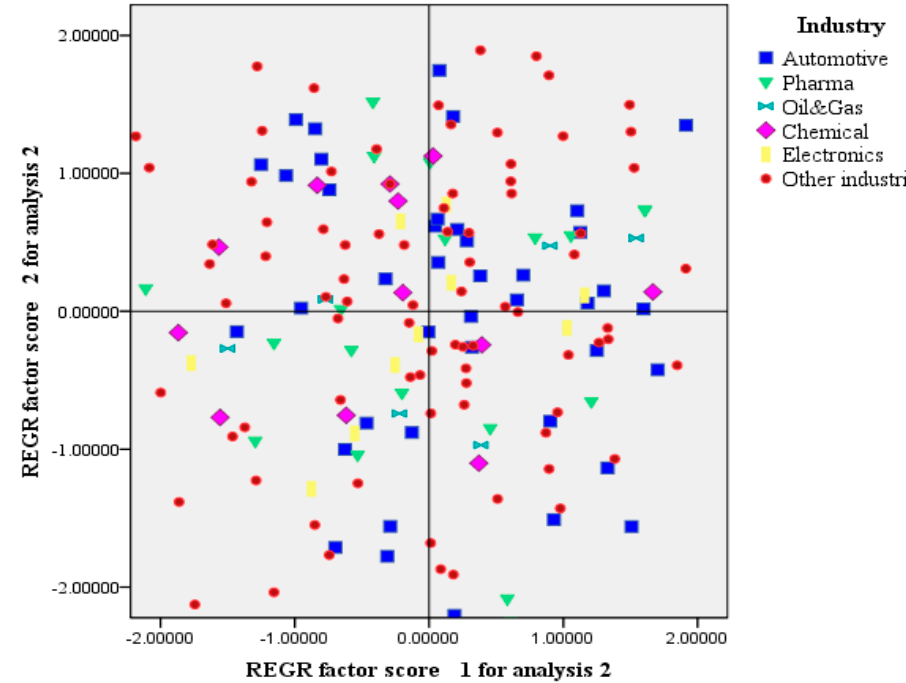
Figure 6. SME representation by industry in terms of the two main components.